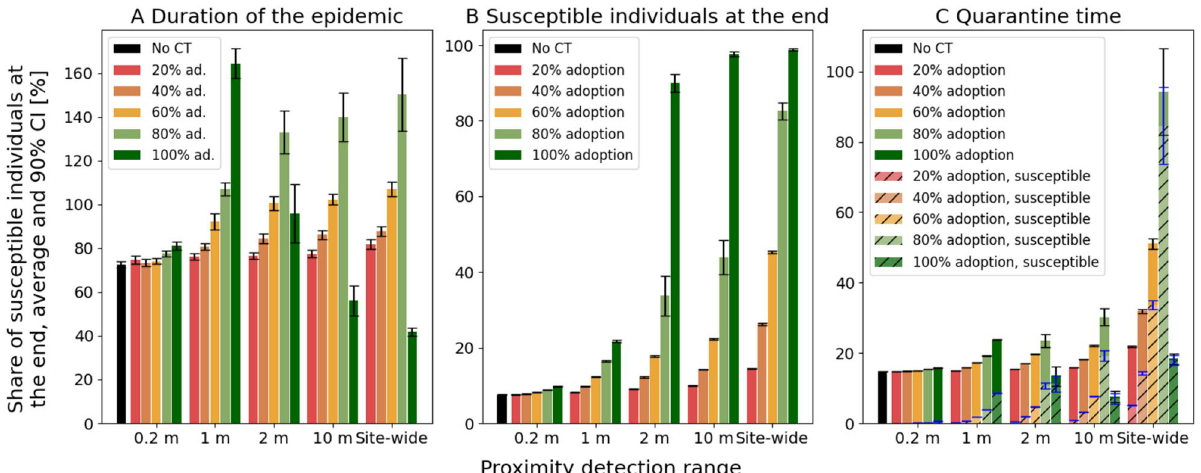
Figure 2. Quarantine time and efficiency measures. Each subfigure illustrates the mean values and 90% confidence intervals based on the used PDRs for CT and the adoption of CT averaged over 30 simulations. A shows the duration of the epidemic. For this, Fig. 1 is not representative, as the curves are averaged and, therefore, take the value of the simulation with the longest duration. B shows the share of susceptible individuals at the end of the epidemic, C shows the average quarantine time per individual, and the average time individuals spend this quarantine time in a susceptible disease